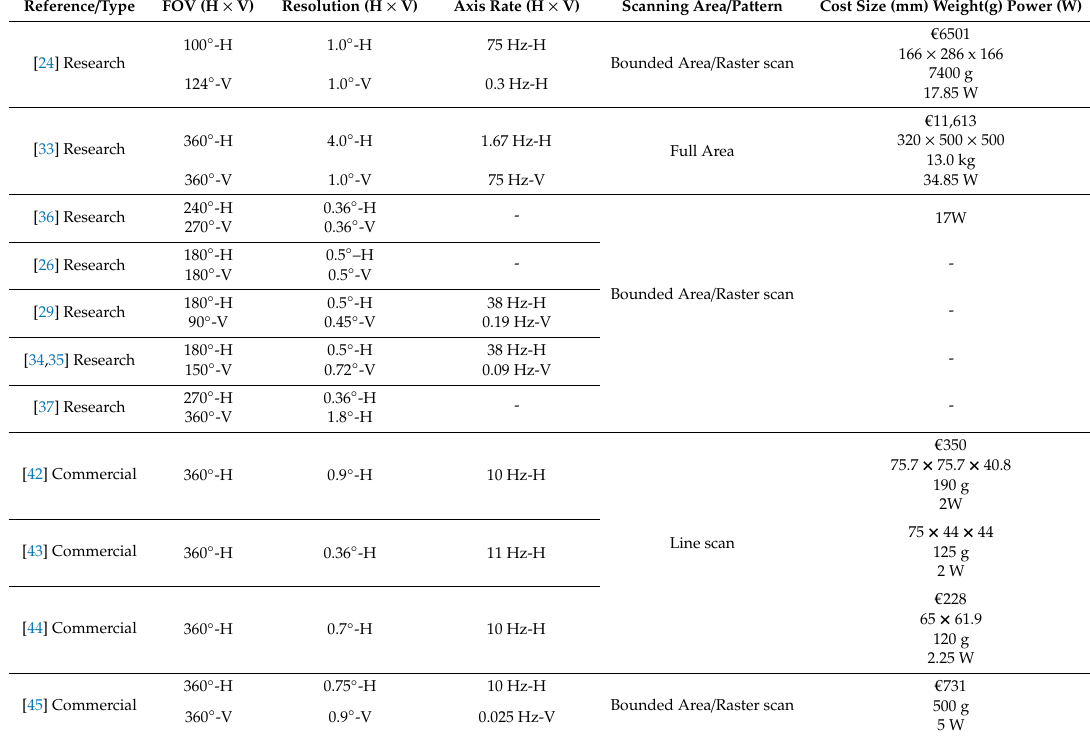
Table 2. Comparison of performance and SWaP specifications for selected electromechanical scanning